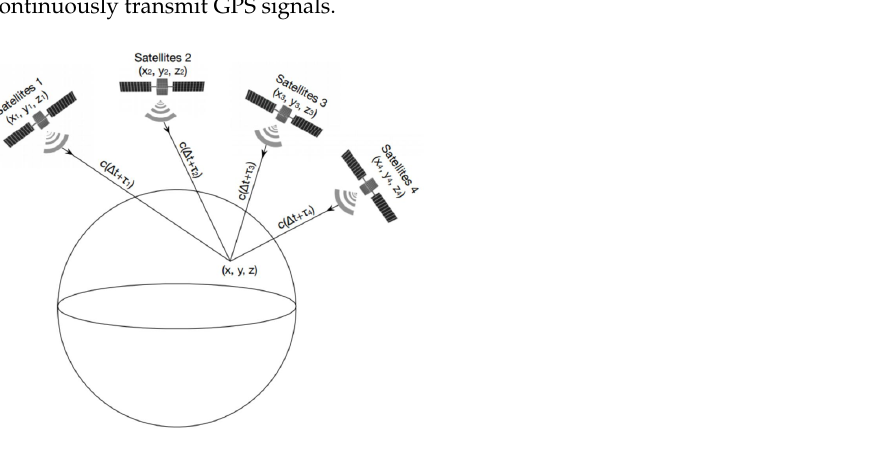
Figure 3. Topological relationship between GPS signal receiver and satellites: typical four-star